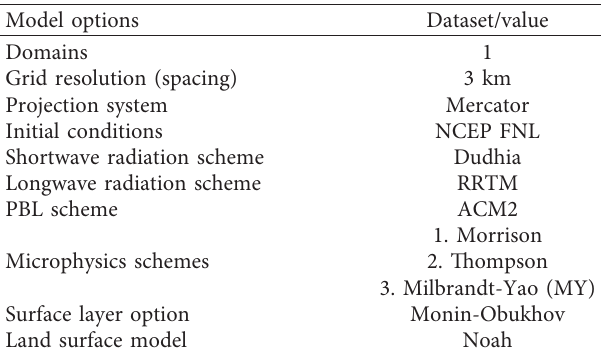
Table 1: Configuration of the WRF model considered for the simulation of